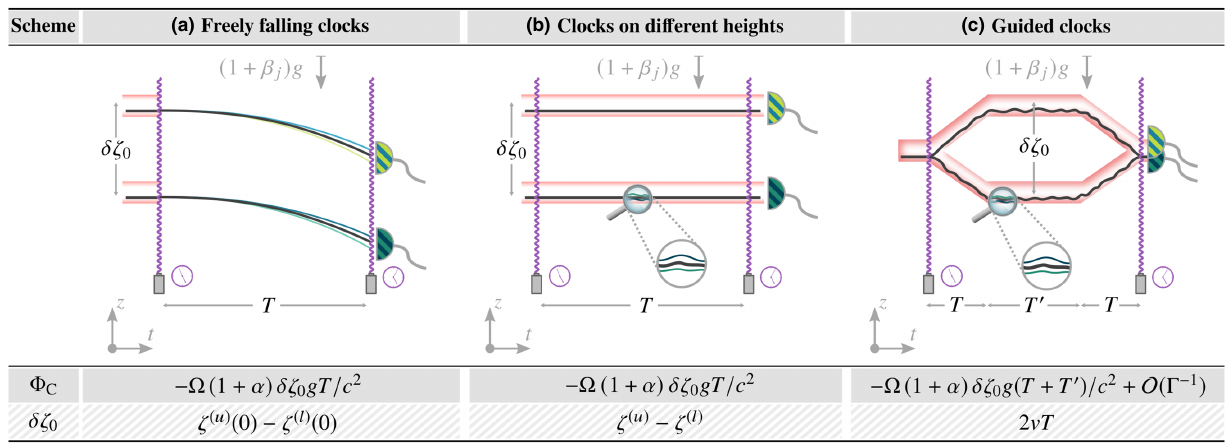
FIG. 1. Comparison of two clocks moving along different configurations in spacetime: two freely falling atoms (a); two clocks trapped at different heights (b); as well as two clocks starting at the same position, guided by two trapping potentials to different heights, and back to the initial height (c). The center of each trap is bordered by red potential barriers, while the unperturbed trajectories z ( t ) of the atoms are represented by black lines. The initialization and readout of the clocks is marked by purple pulses. To show that the detectors project on the internal state of the atom, each detector is colored in blue and green, representing both internal states. The two trajectories caused by a perturbation through the dilaton field with an effective acceleration ( 1 + β j ) g are also drawn with these colors. The differential phases (cid:12) C listed for each geometry in the table all show a sensitivity to UGR tests for a height difference of δζ 0 between the positions of the trap